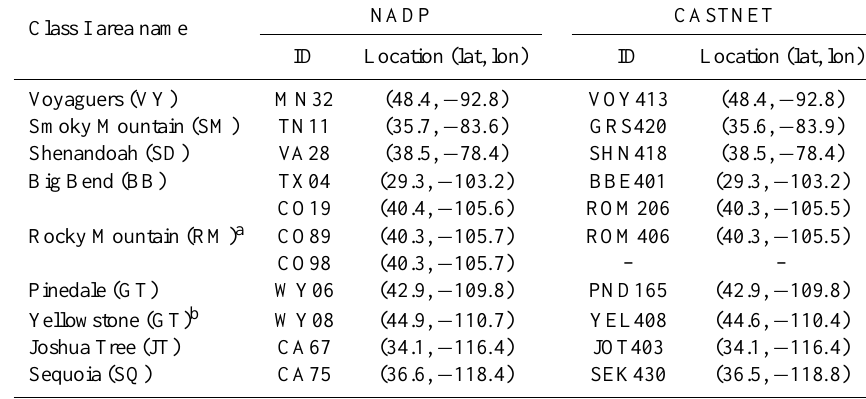
Table 1. NADP and CASTNET sites used for Nr deposition